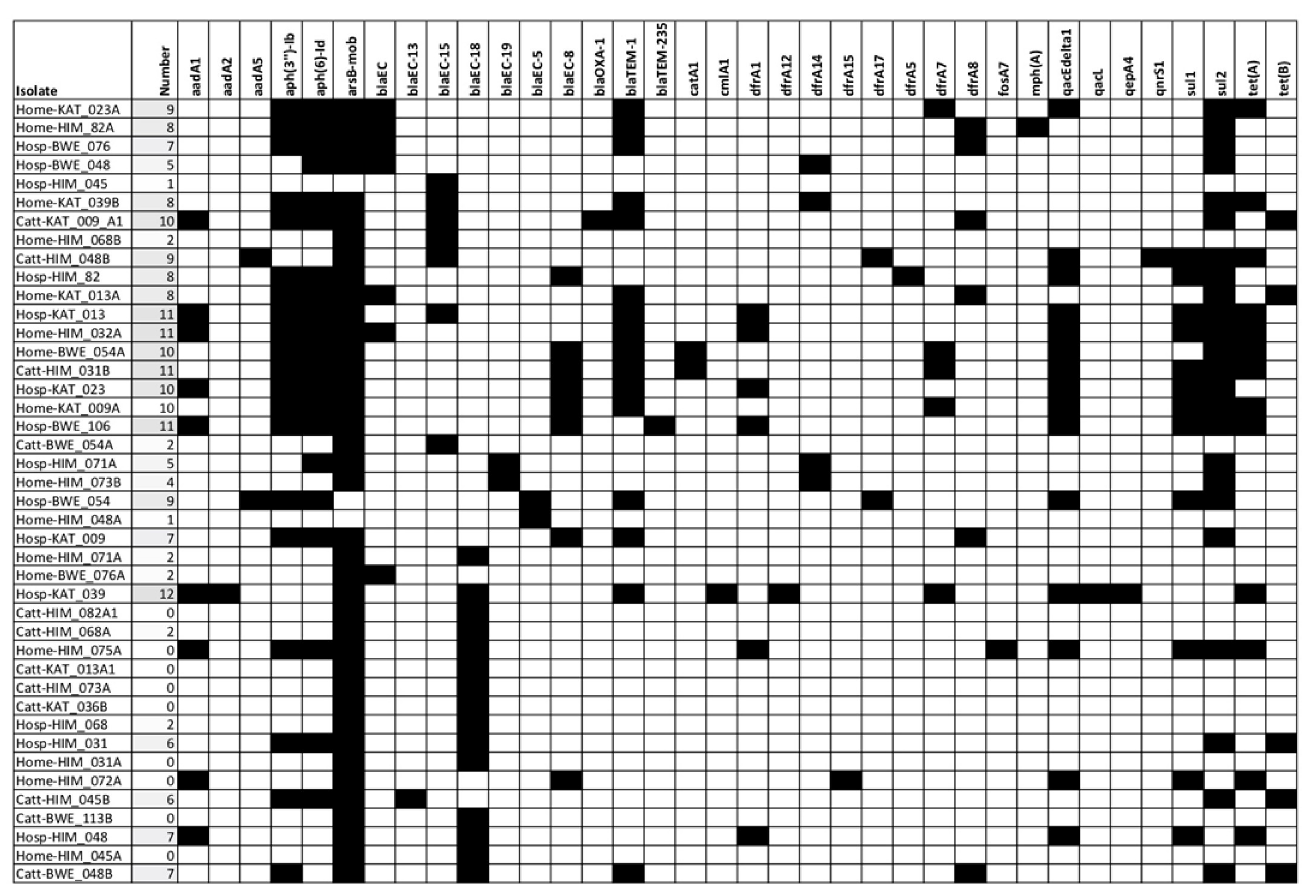
Fig 5. Heat map showing AMR genes found in the genomes of sequenced E . coli isolates. AMR genes are annotated with the NCBI Bacterial Antimicrobial Resistance Reference Gene Database with > 95% coverage. The names of the strains indicated on the y axis are presented in the same order as in Fig 2. aadA1, aadAd2, aadAD5: Streptomycin 3’’-adenylyltransferase; aph(3’’)-Ib, aph(6)-Id: Streptomycin phosphotransferase; arsB-mob: Arylsulfatase B; blaEC, blaEC-13, blaEC-15, blaEC-18, blaEC-19, blaEC-5, blaEC-8: Beta-lactamase; blaOXA-1: Class D beta-lactamases; blaTEM-1, blaTEM-235: Beta-lactamase; catA1: chloramphenicol acetyl transferase; cmlA1: chloramphenicol efflux transporter; dfrA1, dfrA12, dfrA14, dfrA15, dfrA17, dfrA5, dfrA7, dfrA8: trimethoprim resistant dihydrofolate reductase; fosA: fosfomycin thiol transferase; mph(A): macrolide phosphotransferase; oqxB11: RND efflux pump conferring resistance to fluoroquinolone; qacL, qacEdelta1: Small multidrug resistance gene; qepA4: quinolone efflux pump; qnrS1: quinolone resistance gene; sul1, sul2, sul3: sulfonamide resistant; tet(A), tet(B): tetracycline efflux pump (Fig 5).